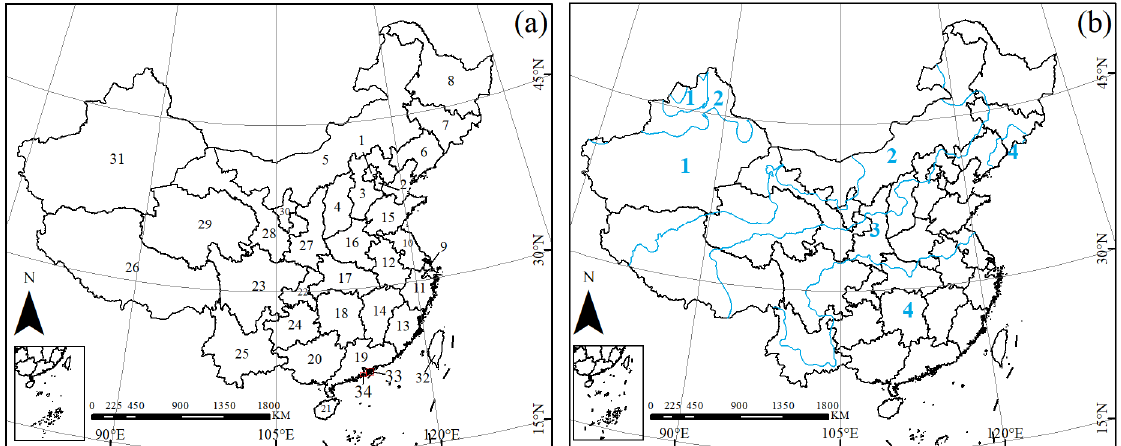
Figure 1. China’s regional map of ( a ) administrative division, and ( b ) arid-humid division. Beijing, Tianjing, Hebei, Shanxi, Inner Mongolia, Liaoning, Jilin, Heilongjiang, Shanghai, Jiangsu, Zhejiang, Anhui, Fujian, Jiangxi, Shandong, Henan, Hubei, Hunan, Guandong, Guangxi, Hainan, Chongqing, Sichuan, Guizhou, Yunnan, Tibet, Shaanxi, Gansu, Qinghai, Ningxia, Xinjiang, Taiwan, Hongkong and Macao are denoted by numbers from 1 to 34 in ( a ), respectively. The arid region (AR), semi-arid region (SAR), semi-humid region (SHR) and humid region (HR) are denoted by numbers 1, 2, 3 and 4, respectively.